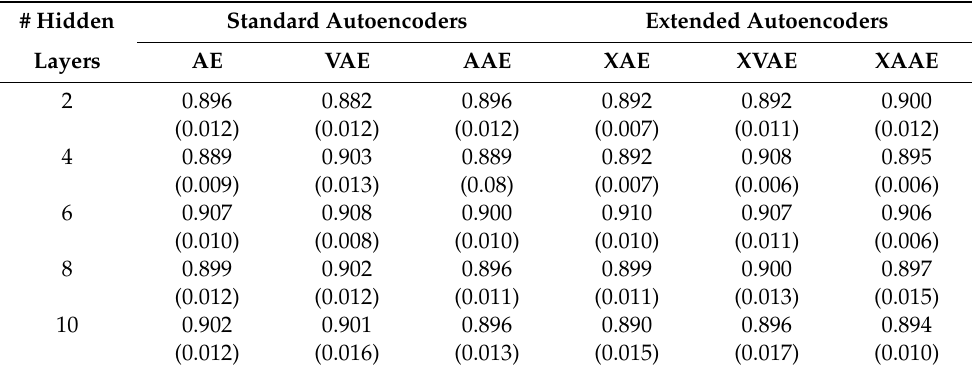
Table 4. AUROC with di ff erent number of hidden layers on MI-V dataset. The number of in parenthesis indicates the standard